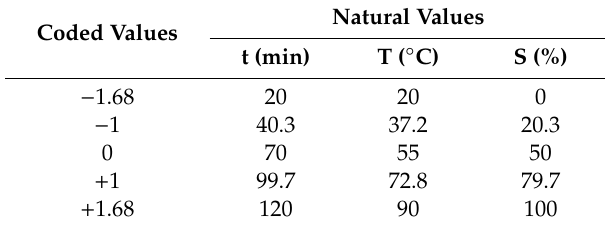
Table 2. Experimental domain of independent variables in the CCCD with 5 range